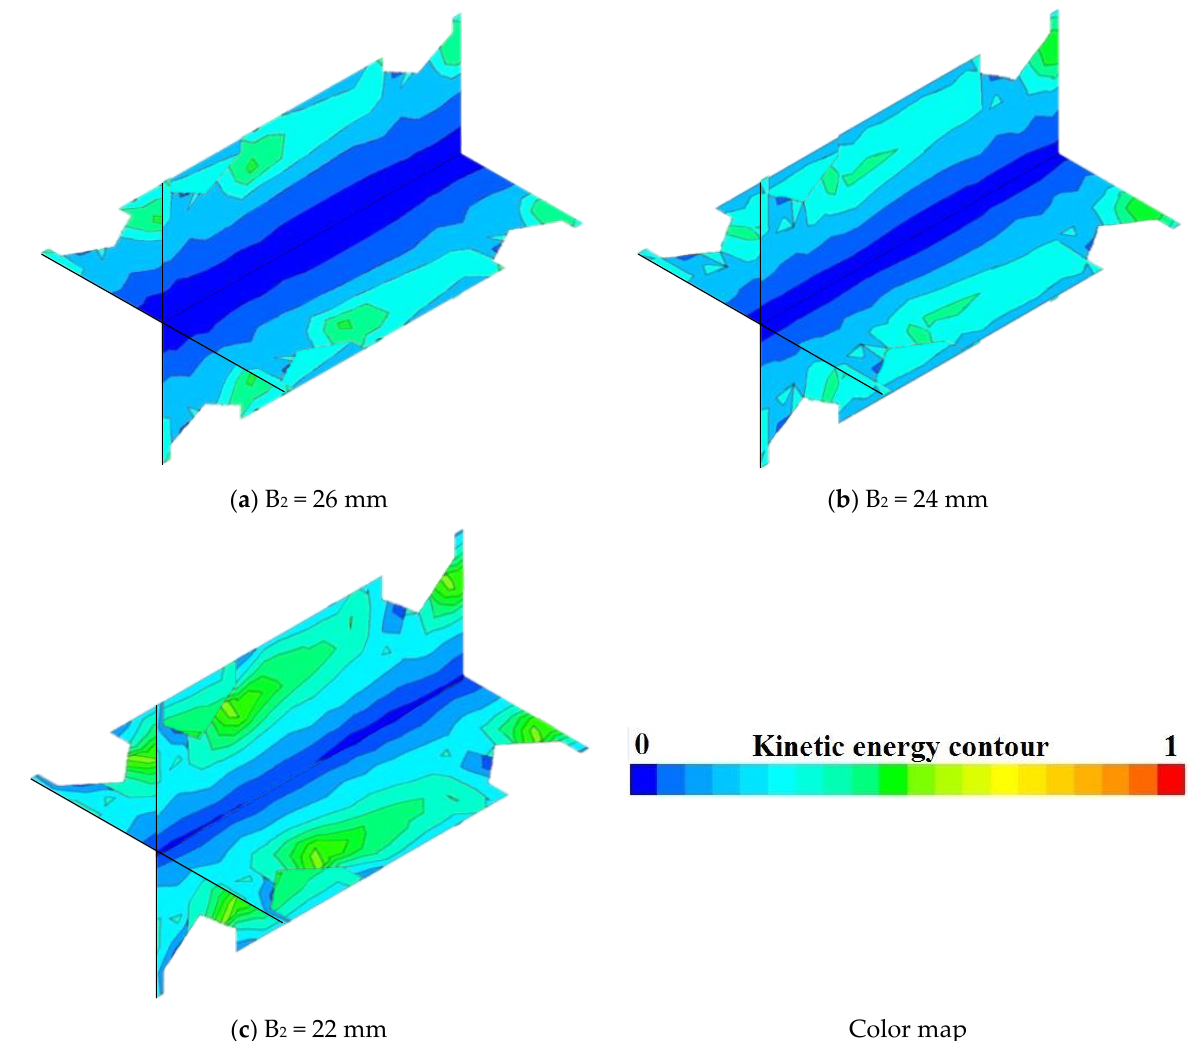
Figure 19. Velocity magnitude contours for various configurations of Case B with different B 2 parameters at R = 15 mm, Re = 15,000, and 𝜑 = 0.5%.